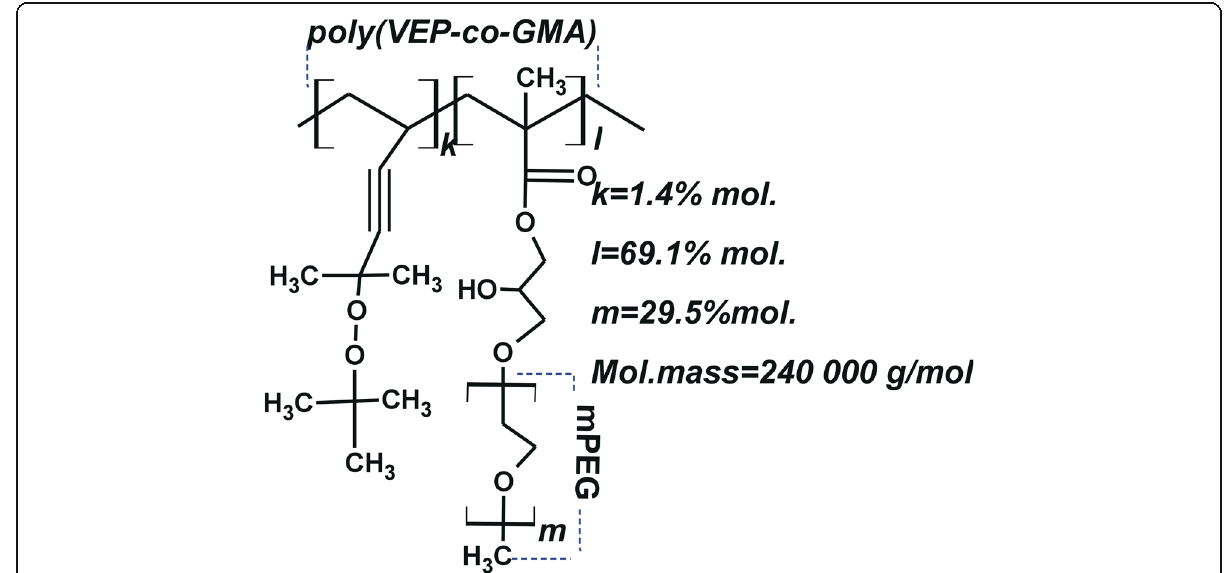
Fig. 2 Schematic structure of the PNC — poly(VEP -co- GMA)- graft -PEG with the main chain on the base of a co-polymer of unsaturated peroxide of 2- tert -butylperoxy-2-methyl-5-hexen-3-in (VEP, denoted by “ k ” ), with side chains of glycidyl methacrylate (GMA, denoted by “ l ” ) and polyethylene glycole (PEG, denoted by “ m ”